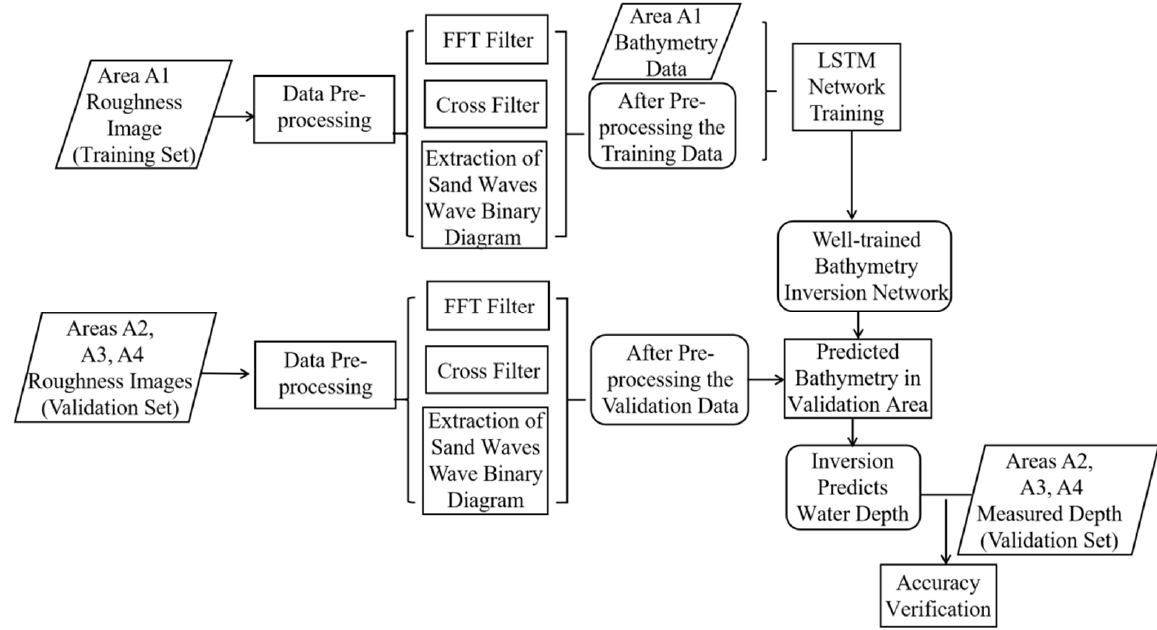
Figure 4. Experimental flow. Slanted boxes indicate input data, straight boxes indicate actions, rounded boxes indicate output data, and arrows indicate sequence.